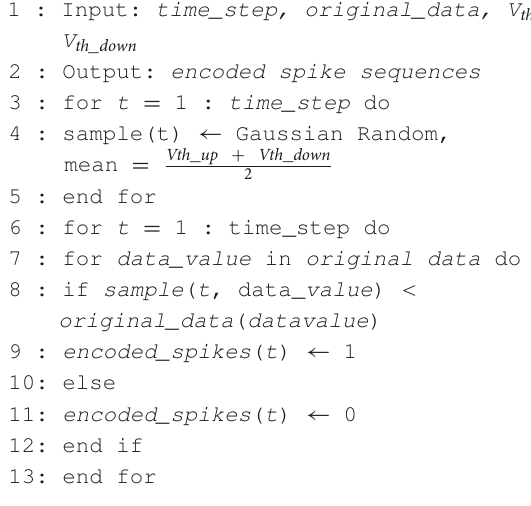
Algorithm 1 | Temporal Gaussian random sparse